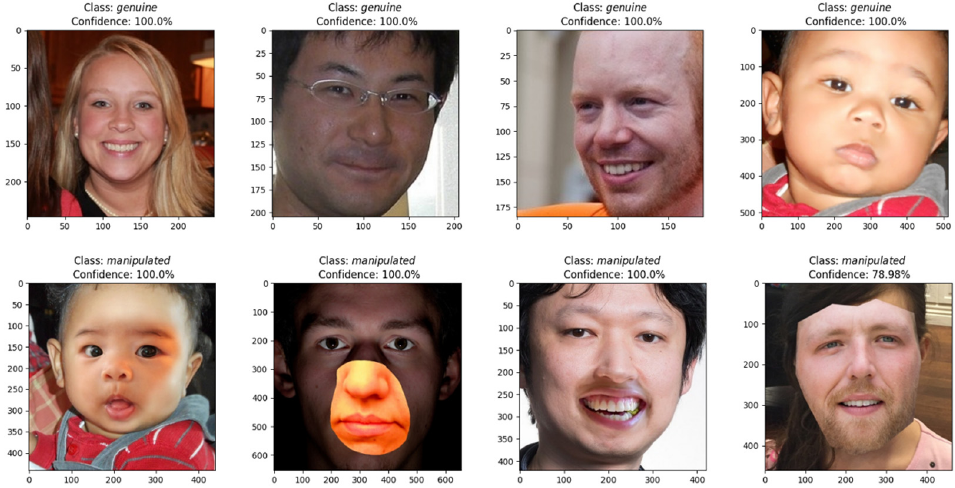
Figure 6. The model predictions for four genuine face images and four manipulated face images with the corresponding prediction confidence.